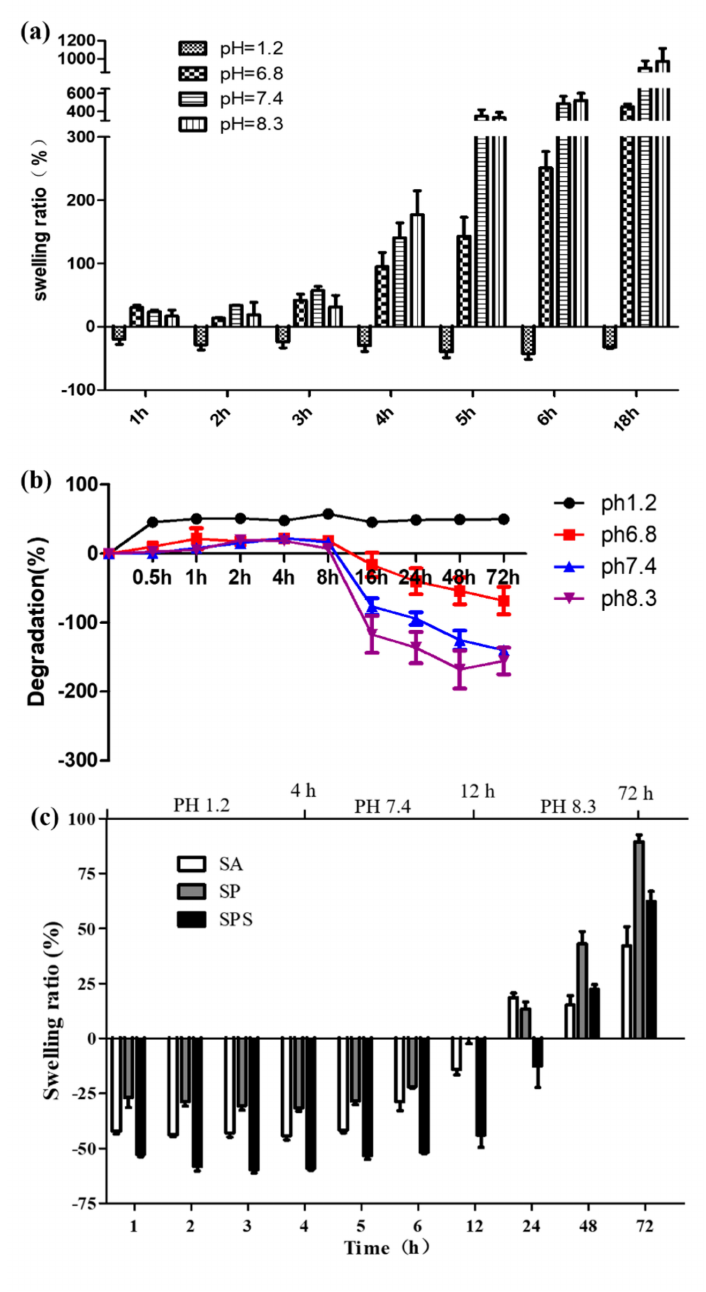
Figure 5. ( a ) The swelling ratio of the SPS hydrogel sphere after immersed in the phosphate bu ff er solution for 1 h, 2 h, 3 h, 4 h, 5 h, 6 h and 18 h in the condition of pH 1.2, pH 6.8, pH 7.4 and pH 8.3, separately; ( b ) the degradation ratio of the SPS hydrogel sphere for 0.5 h, 1 h, 2 h, 4 h, 8 h, 16 h, 24 h, 48 h and 72 h in the condition of pH 1.2, pH 6.8, pH 7.4 and pH 8.3, separately; ( c ) the swelling ratio of the SA, SP and SPS hydrogel spheres after immersion in the PBS solution in the condition of pH 1.2 for 4 h, and then pH 7.4 for 8 h, and finally pH 8.3 for 60 h. (mean ± SD, n =